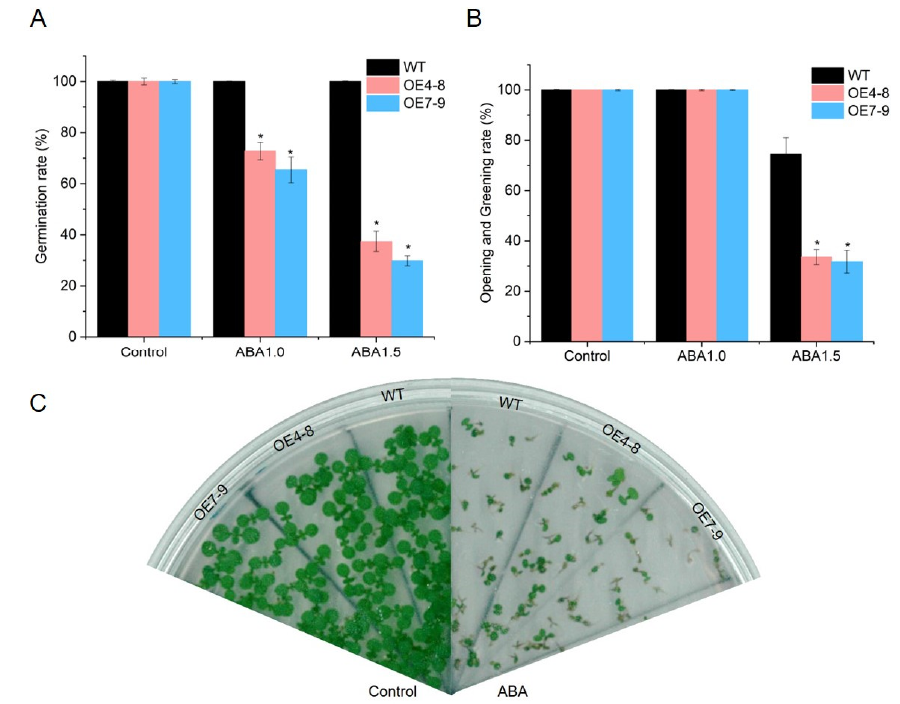
Figure 9. Overexpression of SlCML39 increases Arabidopsis thaliana sensitivity to ABA. ( A ) The ger- mination rate of SlCML39- overexpressing lines (OE4-8 and OE7-9) and wild-type (WT) Arabidopsis seeds on 1/2 MS medium supplementing 1.0 and 1.5 µm ABA. Germination was recorded daily up to 5 days. ( B ) Seedlings with open and green leaves were recorded at 10 days. ( C ) The photographs were taken at 10 days. The bar represents the mean ± SD values of three replicates ( n = 3). * p < 0.05 by Student’s t-test.